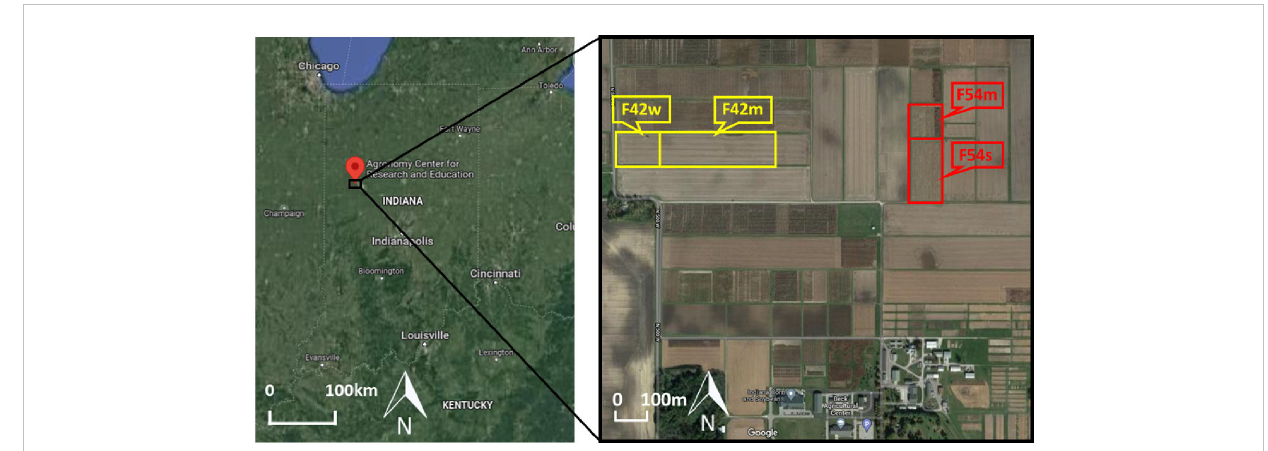
FIGURE 1 Locations (highlighted by yellow and red boxes) of sorghum experiments at the Purdue University ’ s Agronomy Center for Research and Education (ACRE). Cal panels were planted in Fields F42w and F54m, and Tc panels were planted in Fields F42m and F54s on alternating